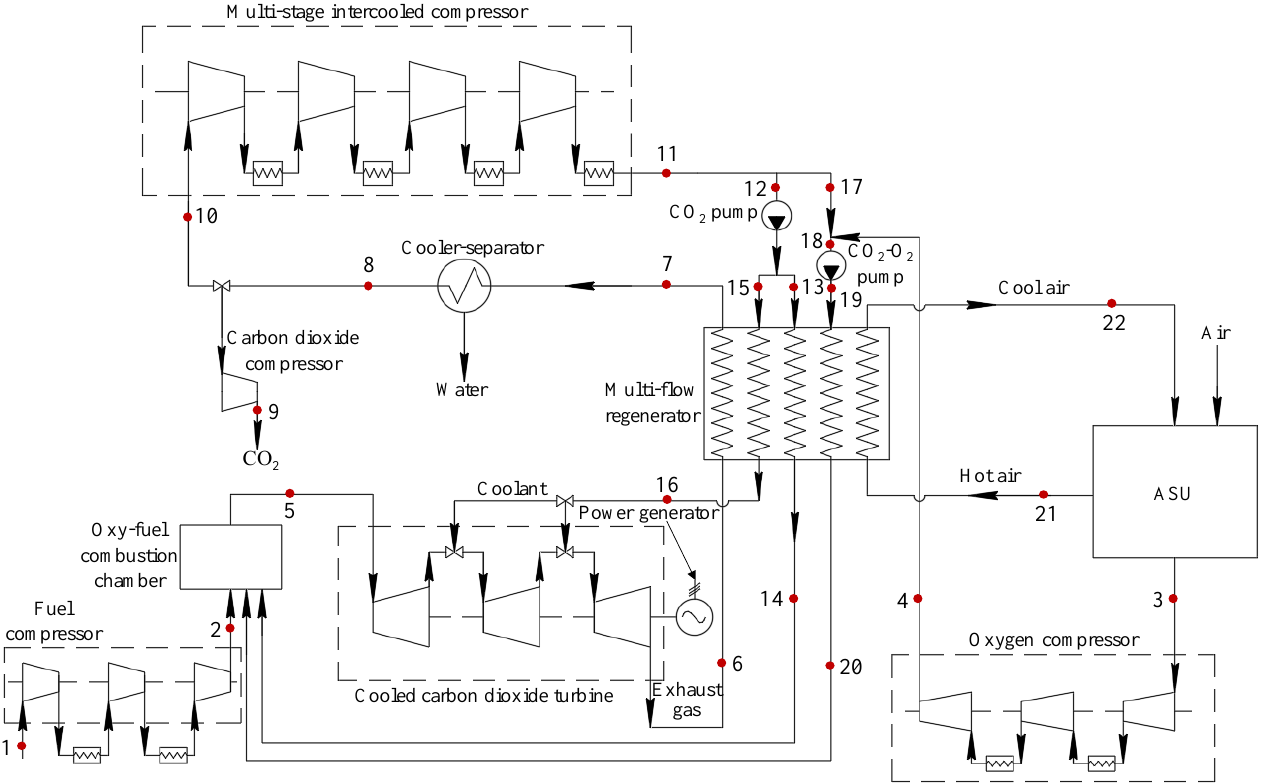
Figure 1. The Allam cycle with low-potential heat of the air used in the multi-flow regenerator. The main flow enters the multi-stage intercooled compressor. The compressed flow is split in two and directed towards the entrances of CO 2 and CO 2 –O 2 pumps. The inlet flow of pump CO 2 –O 2 is pre-mixed with compressed oxygen. The high-pressure pumps’ exit flows enter the multi-flow regenerator and after heating, are directed toward to the combustor. The cycle is thus closed.